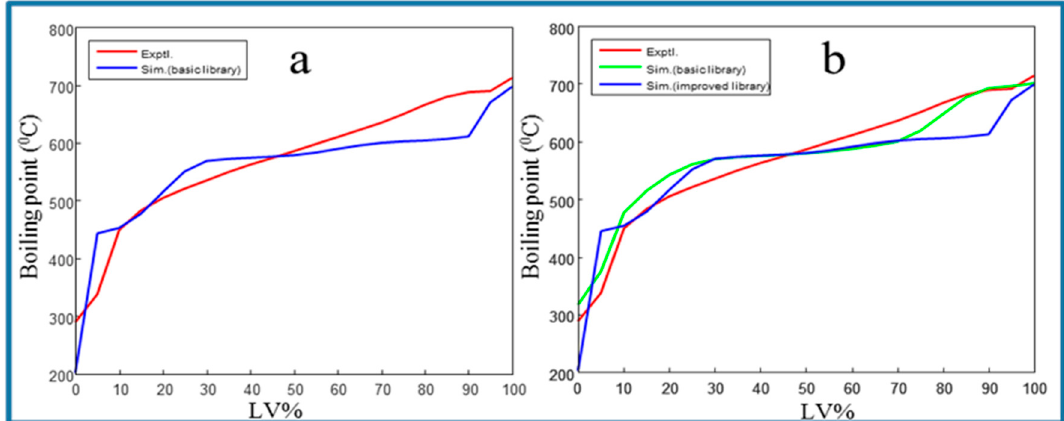
Table 1. Simulated residue feed composition contents with basic and improved feed library in HCR.